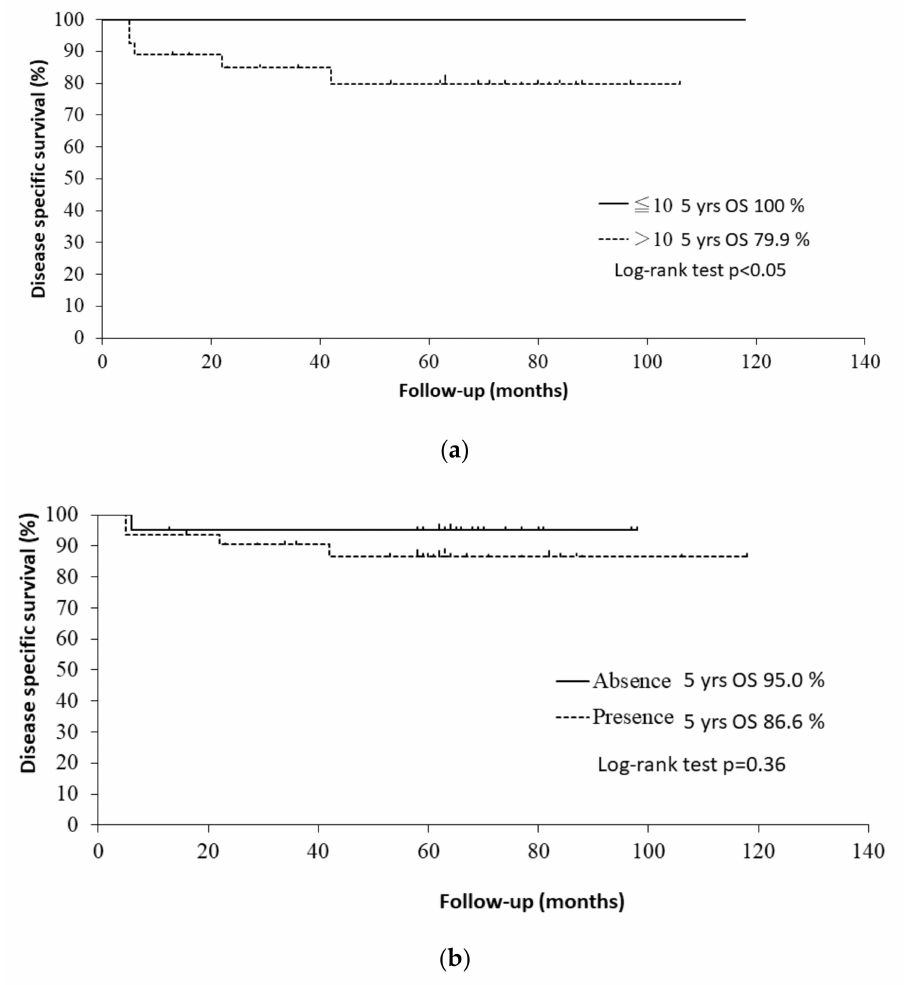
Figure 3. ( a ) Kaplan–Meier curves for disease-specific survival of HPV-positive patients with a ≤ 10 and with a > 10 pack-years smoking history. ( b ) Kaplan–Meier curves for disease-specific survival of HPV-positive patients with/without alcohol